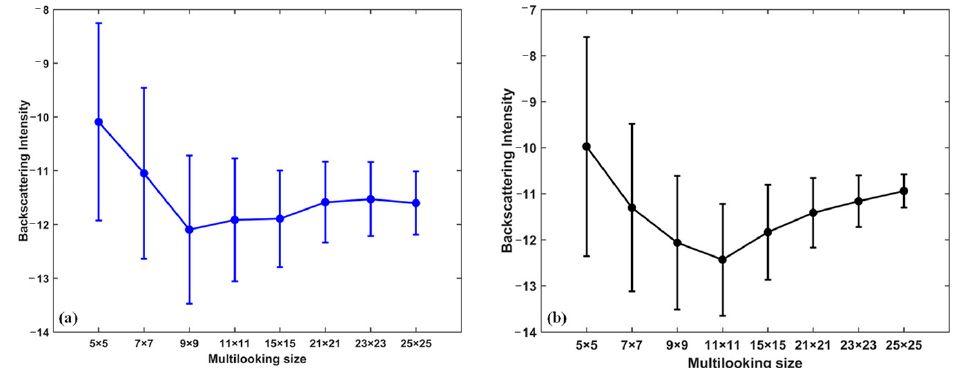
Figure 6. Backscattering intensity and spatial variations of pixels at the HH channel for different multilooking sizes: ( a ) pixel A in Mabounie; ( b ) pixel D in Mondah.